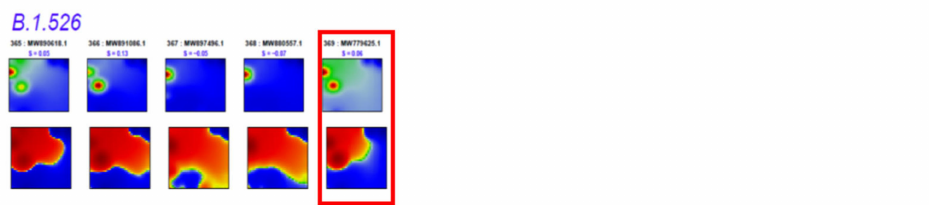
Figure A5. Examples of SOM-portraits of individual SARS-CoV-2 genomes of selected Pangolin- variants in standard and ‘coastline’ scale (upper and lower raw, respectively). The portraits illustrate individual features and partly deviating or even showing outlier properties (red frames). Deviations can appear because of variable mutations, methodical differences (sequencing depths affecting mutations detected) or classification errors. Portrayal thus enables control of the genomes on a ‘personalized’ basis. The full gallery of SOM portraits of SARS-CoV-2 genomes studied is provided in Supplementary Materials: File S1.